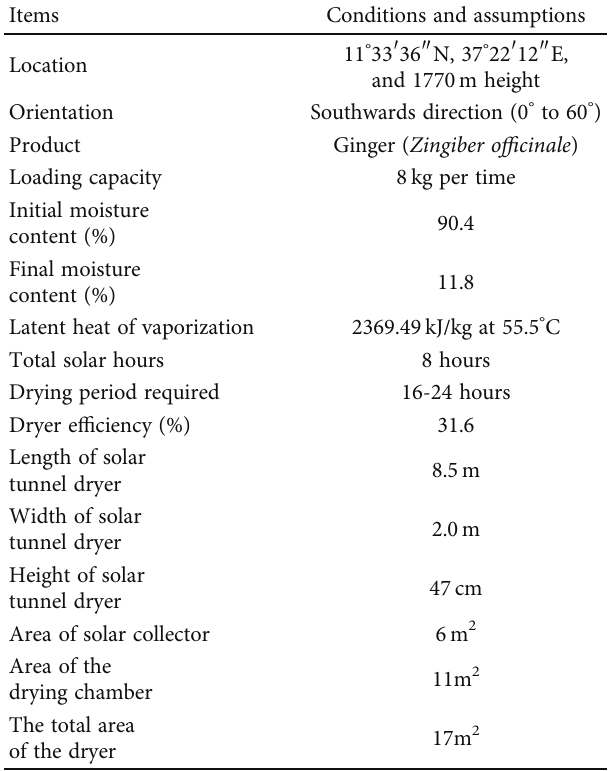
Table 1: Design conditions and assumptions for the design of the